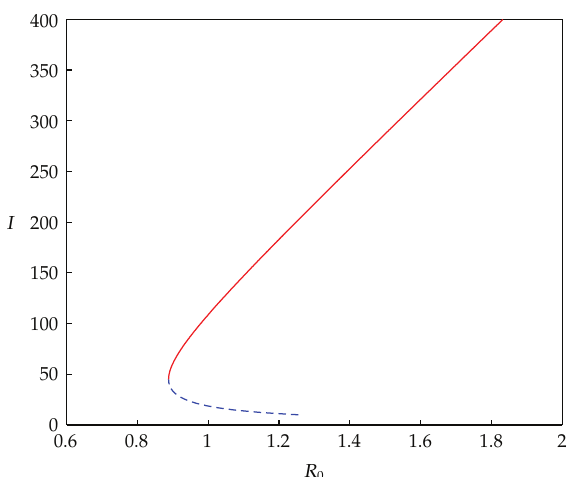
Figure 3: The figure of I ∗ , I 1 and I 2 versus R 0 that shows a backward bifurcation with endemic equilibrium when R 0 < 1, where Corollary 2.3